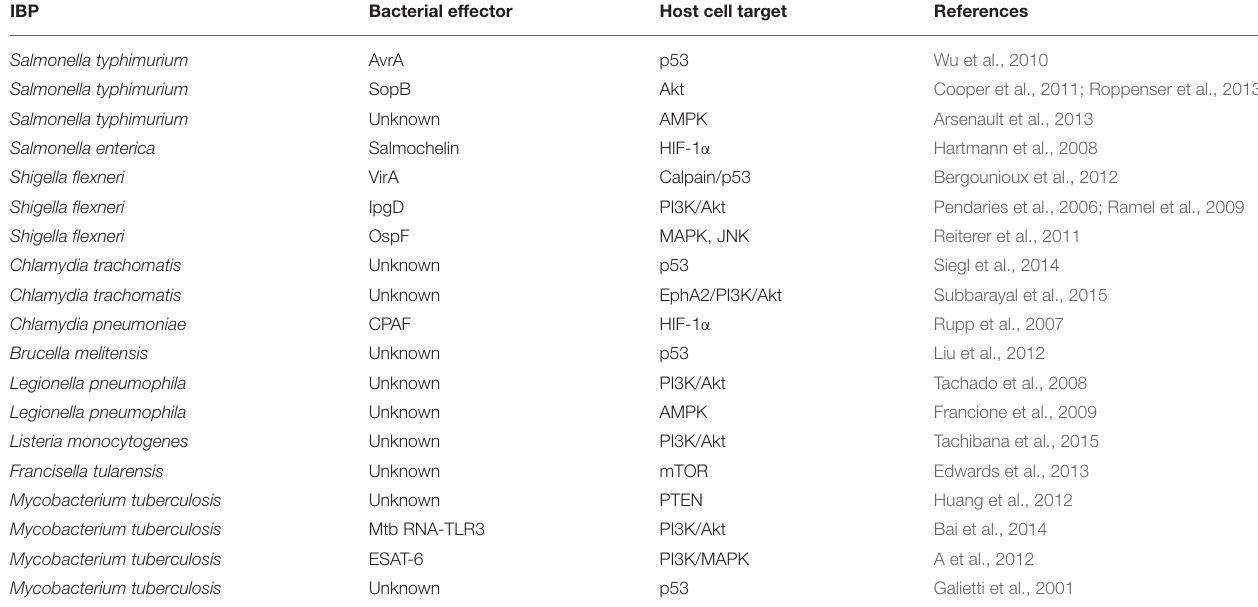
TABLE 1 | Interactions of IBP effectors with their host cell targets.